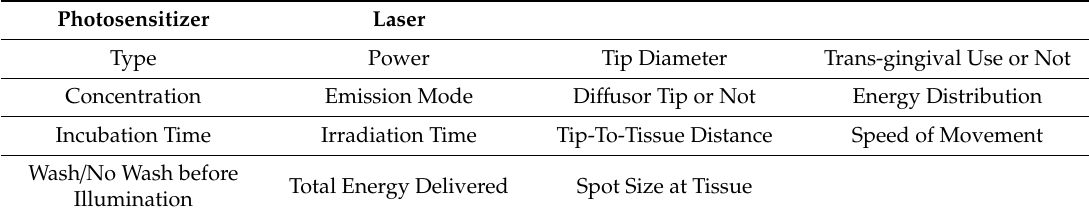
Table 13. Ideal reporting required for aPDT treatment regimen